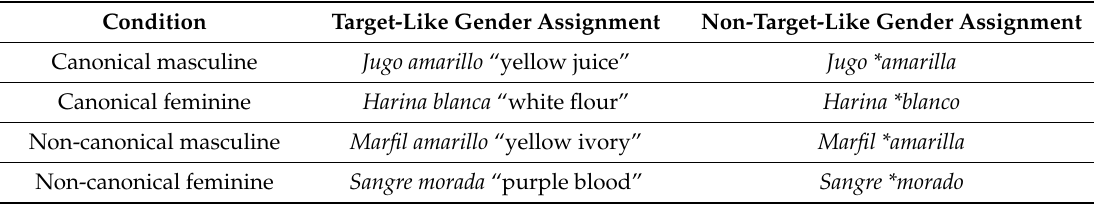
Table 4. Gender assignment production